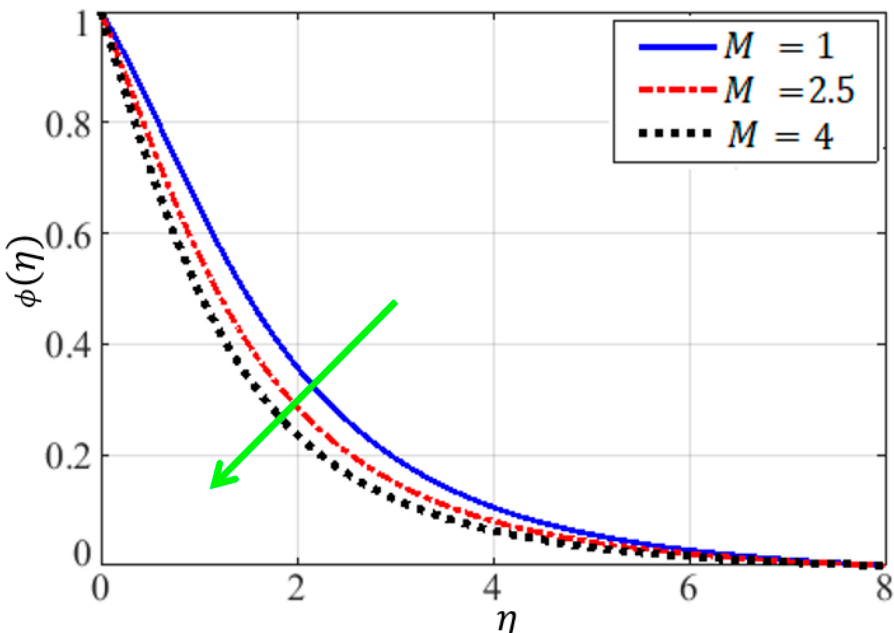
Figure 12. Impact of magnetic field parameter on fluid’s concentration.